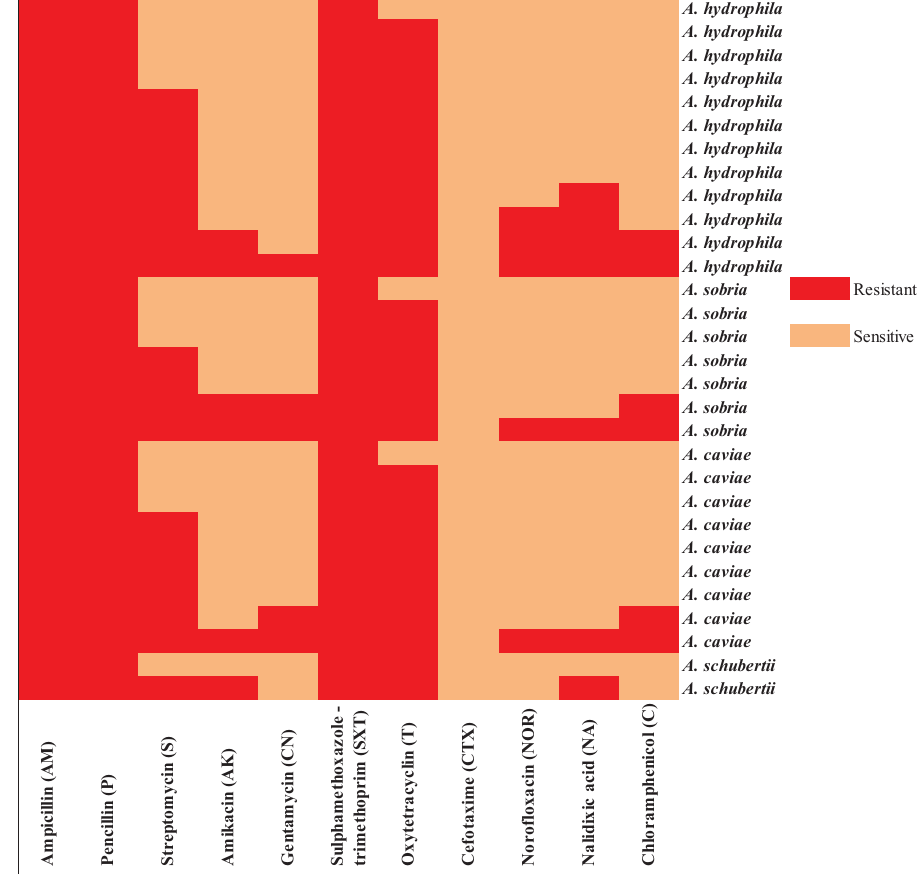
Figure-2: Heat map showing a summary of antibiogram for Aeromonas spp. isolates. Red blocks represent resistance, and light blocks represent sensitivity to the antimicrobial